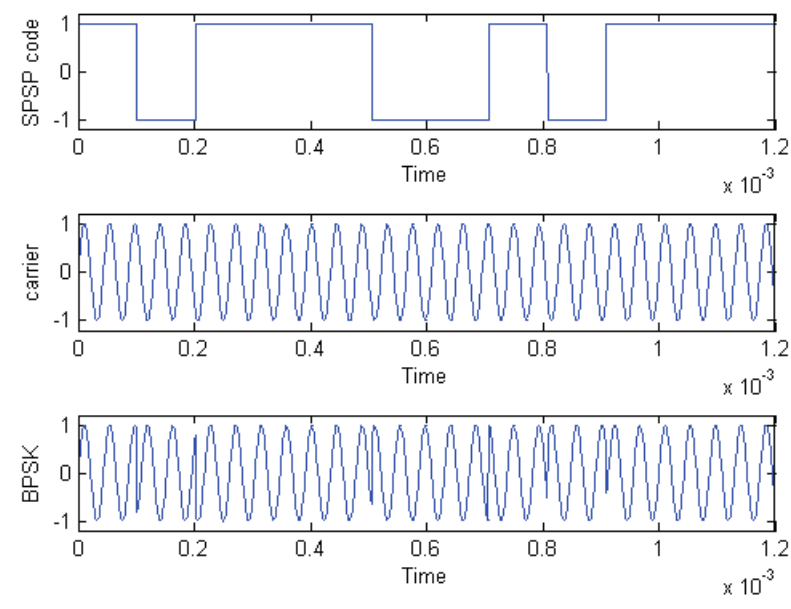
Figure 15. The simulation result of BPSK